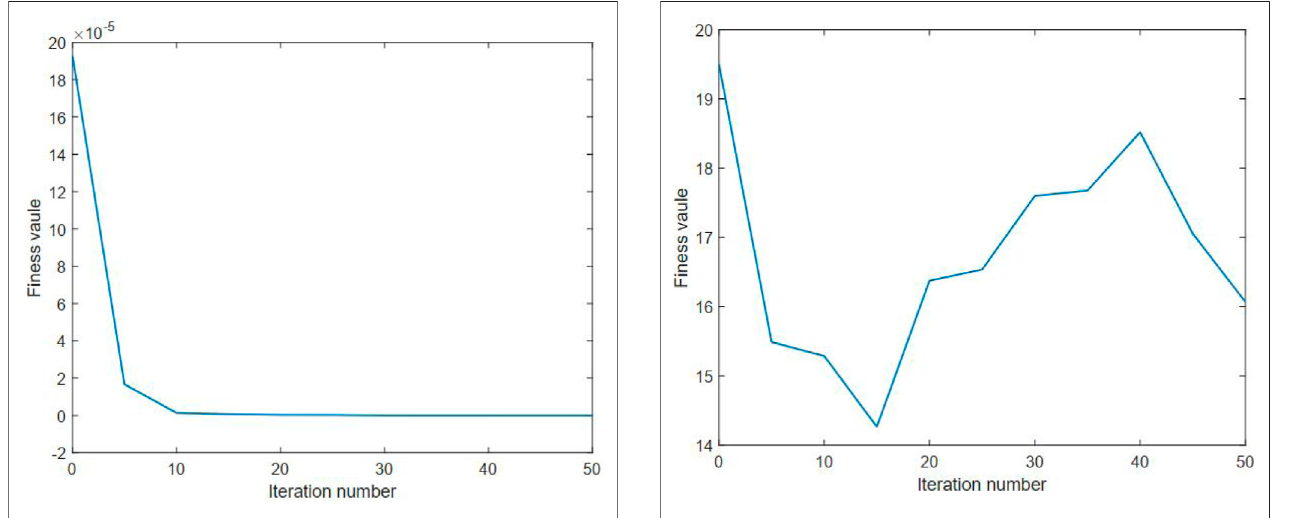
FIGURE 3 | Average fi tness curve of the lower level for the benchmark test function.